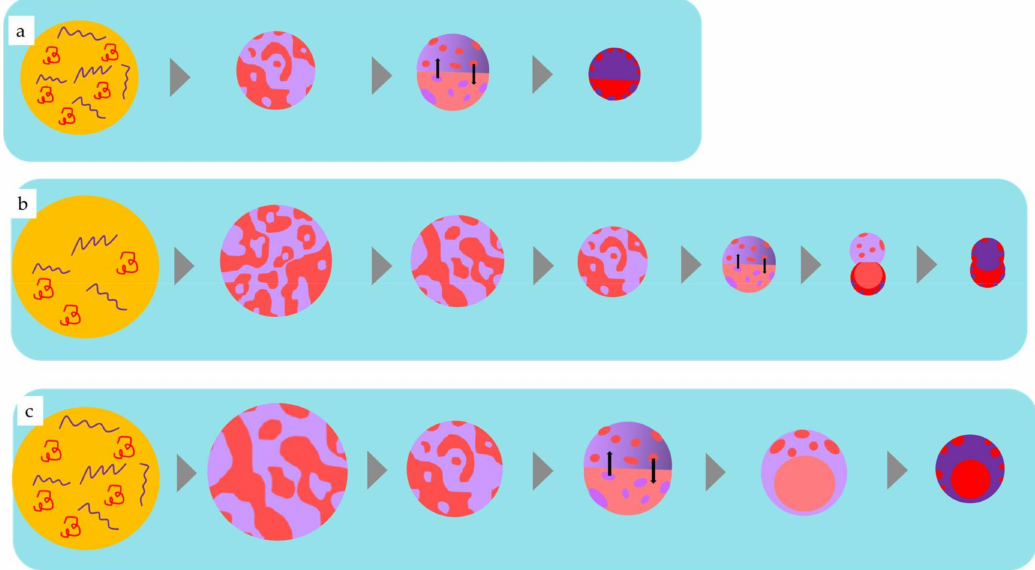
Figure 4. Plausible temporal evolution of phase separated morphology for PBTPA/PMMA composite microsphere ( a ) B1, ( b ) C1, ( c ) A1, red: PBTPA, blue: